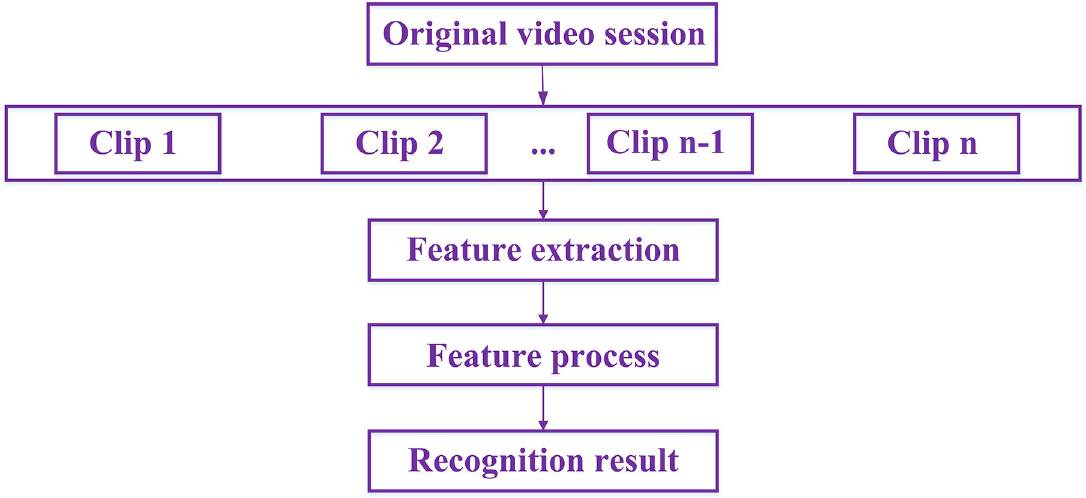
Fig 1. The general flowchart about behavior